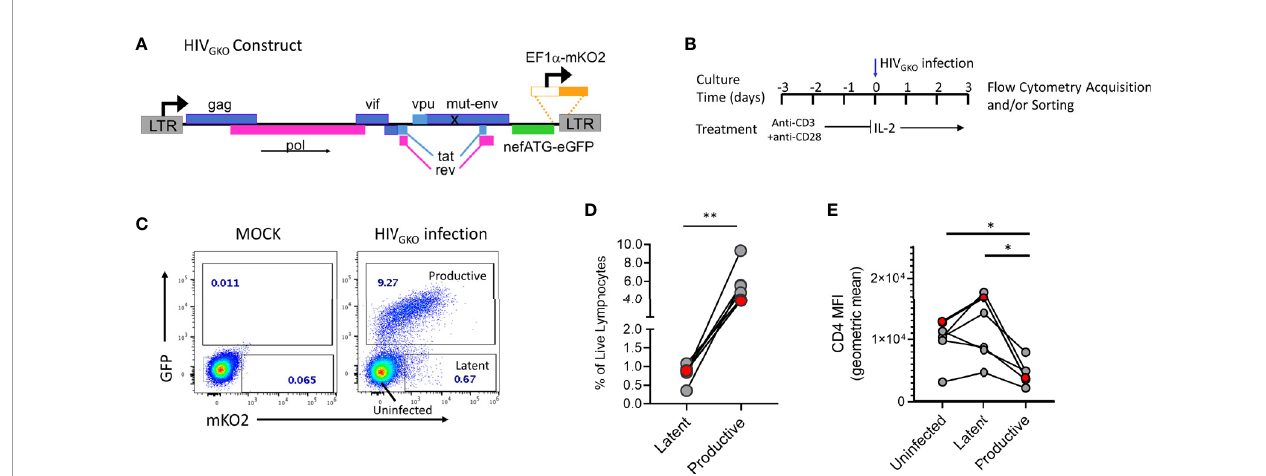
FIGURE 1 | HIV GKO infection in tonsil derived CD4 + T cells. (A) HIV GKO viral construct showing mutated env gene, nef gene replaced by an eGFP reporter, and insertion of EF1a promoter directly upstream of mKO2 reporter. (B) Schematic showing experimental design for activation and infection with HIV GKO of puri fi ed tonsillar CD4 + T cells. (C) Representative fl ow plot showing expression of dual fl uorescent reporters from HIV GKO on day 3 post-infection. (D) Summary data from 6 tonsil donors with frequency of productive and latent infected cells based on gating shown in panel (C) . (E) Mean fl uorescent intensity of cell surface protein expression for CD4 on cells infected with HIV GKO on day 3 post-infection. Red data points in panels D and E indicate the individual donor used for single cell analyses in single cell RNA Seq experiments. Paired t test was performed to compare Uninfected, Latent, and Productive cell populations, *p < 0.05, **p <